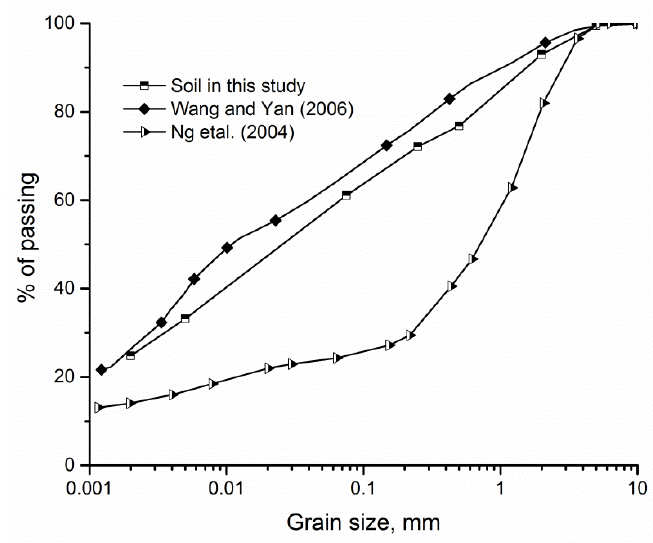
Figure 2. Grain-size distribution curves.